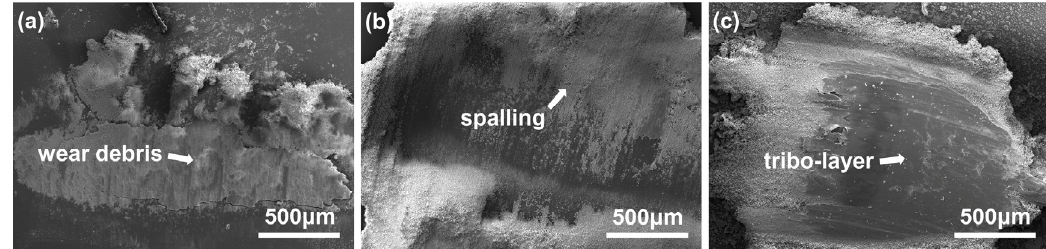
Figure 9. SEM of the Al 2 O 3 counter ball, mating with NMA self-lubricating composite: ( a ) RT, ( b ) 400 °C, and ( c ) 800 °C.